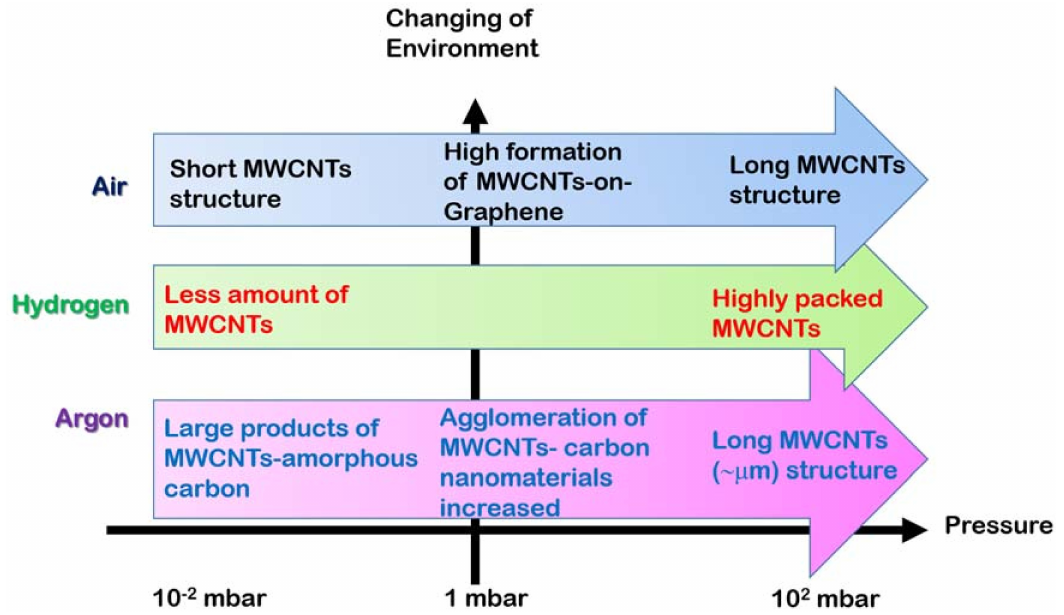
Figure 10. Growth phenomenon of the MWCNT in different environments and at different